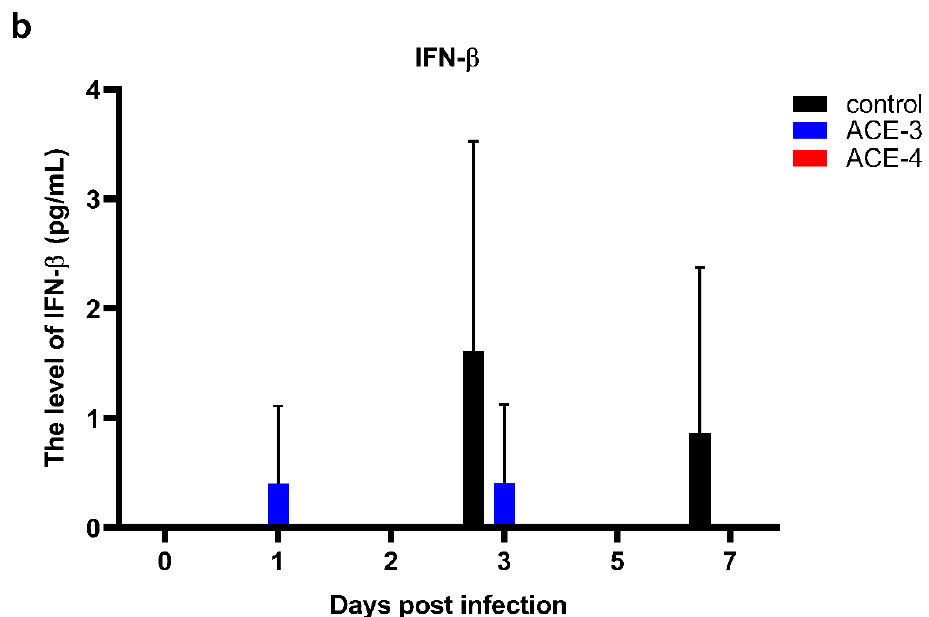
Figure 4. ACE-3 and ACE-4 may inhibit DENV replication by enhancing the secretion of IFN- α . The levels of antiviral cytokines, ( a ) IFN- α and ( b ) IFN- β , in Meg-01 cells treated with A. cinnamomea extracts after DENV infection. All the values represent as mean ± SEM of three experiments. p values were calculated using two-way ANOVA, statistically significant difference * p < 0.05, ** p < 0.01,*** p <0.001,**** p <0.0001 compared to the control.